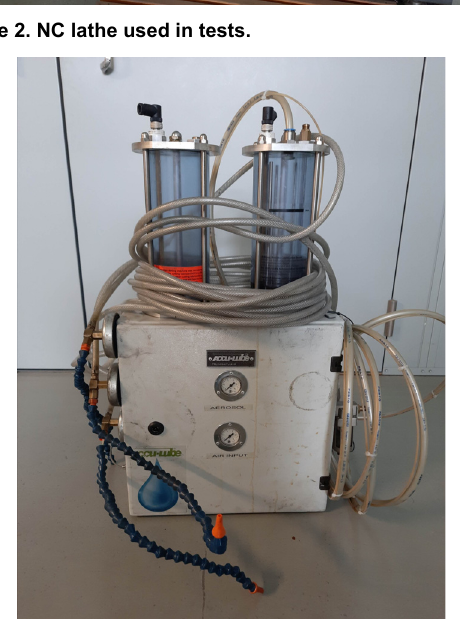
Figure 3. Oil mist producing device.